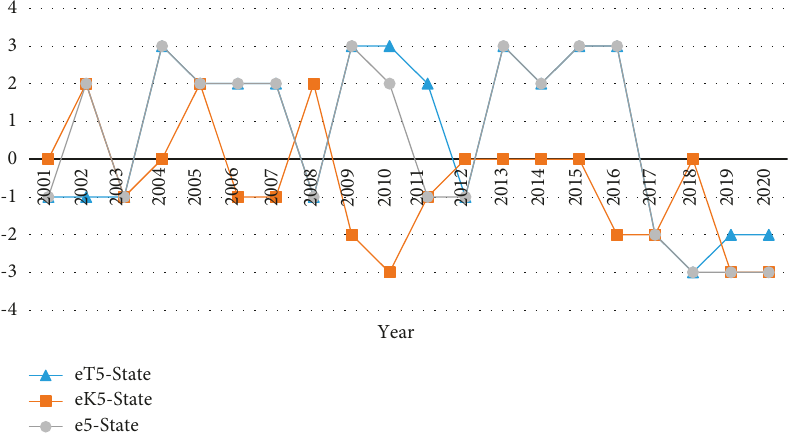
Figure 21: Decoupling of energy efficiency, energy structure, and carbon emission of the nonmetallic sector from 2001 to 2020.